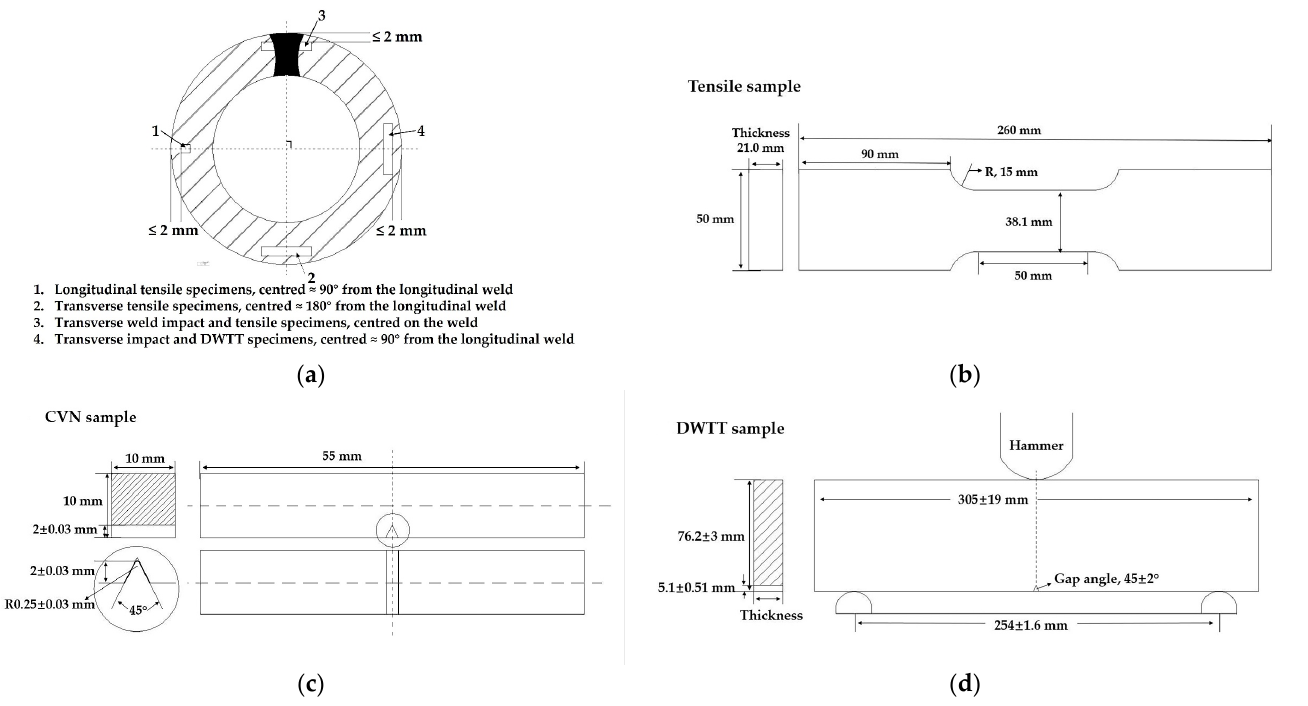
Figure 1. Schematic diagram of specimen positions ( a ) for performance tests and the engineering drawings of tensile ( b ), impact tests ( c ) and DWTT ( d ).